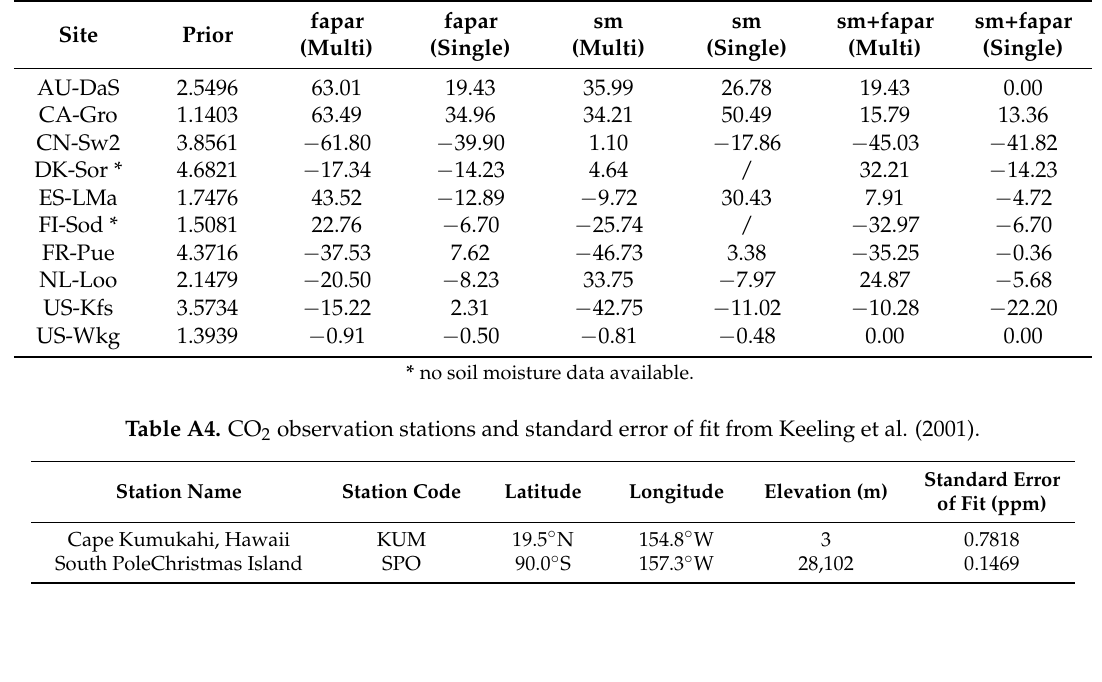
Table A3. RMSE reduction (%, positive value means RMSE was reduced) for gross primary productivity (GPP) simulation with prior and different assimilation methods, ‘sm’ with soil moisture solely, ‘fapar’ with FAPAR solely, ‘sm+fapar’ with combination of soil moisture and FAPAR data, ‘multi’ denotes multi-site assimilation, and ‘single’ denotes single-site assimilation.